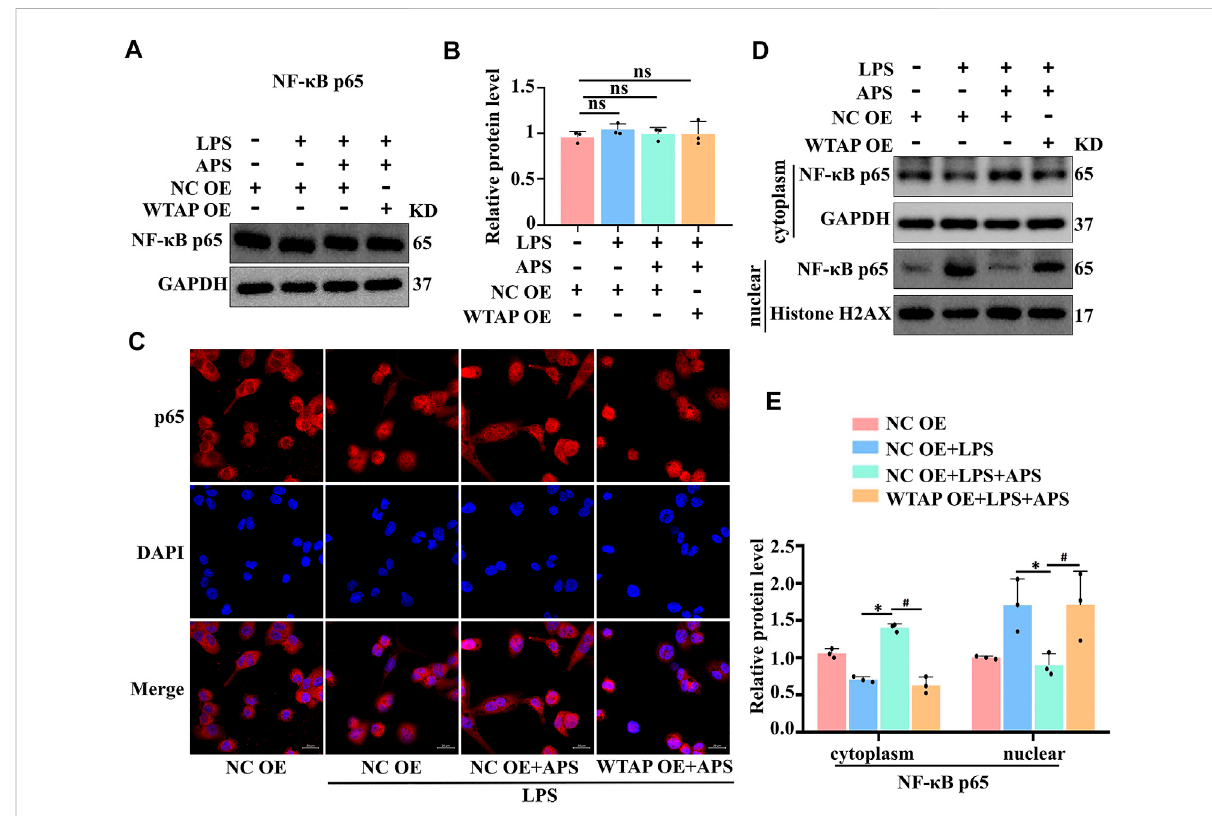
FIGURE 5 APS regulates IL-6 expression through WTAP-mediated p65 nuclear translocation. THP-1 macrophages were transfected with WTAP overexpressionplasmidprior totreatment withAPS. (A) NF- κ bp65proteinexpressionwasdetectedbywesternblot. (B) Densitometryquanti fi cation of protein. (C) The localization of NF- κ b p65 (red) was observed with immunofuorescence, and the nuclei (blue) were stained with DAPI, scale bar, 20 μ m. (D) The nuclear translocation of p65 was analyzed, and its localization in the cytosol and nucleus was separately quanti fi ed by western blot. (E) Densitometry quanti fi cation of protein. * p < 0.05 compared with NC OE + LPS group. # p < 0.05 compared with NC OE + LPS + APS group. Data represent the mean ± SEM. n = 3 per